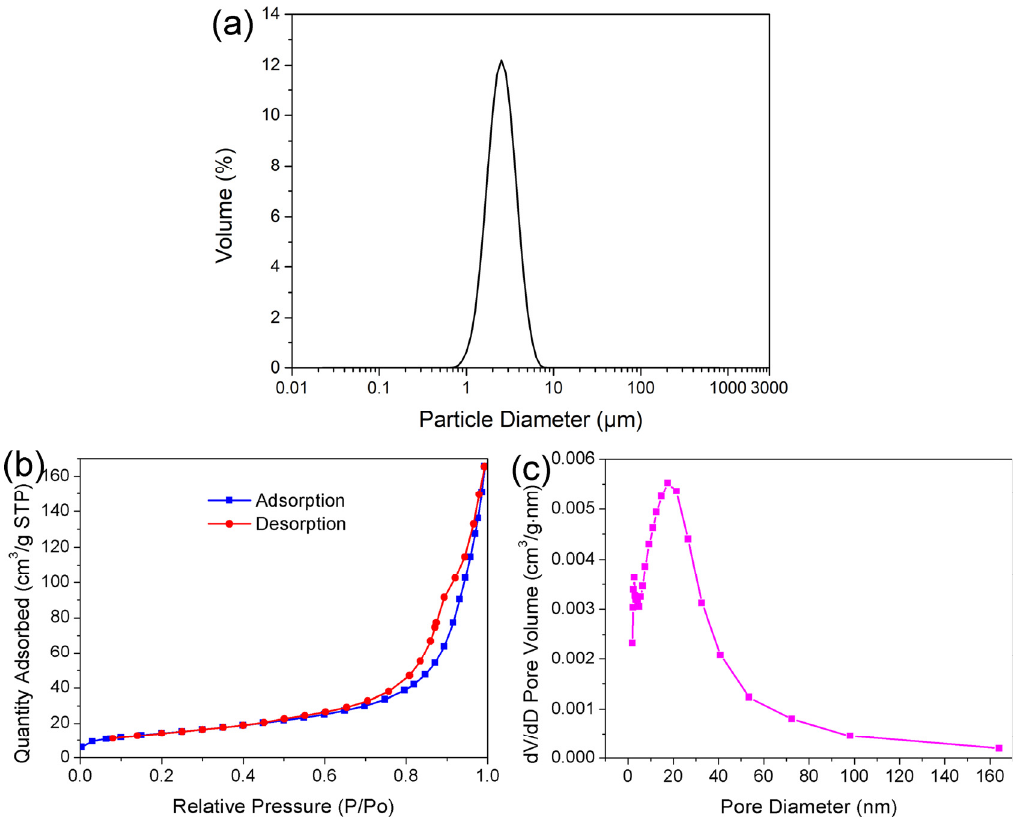
Figure 4. Particle size distributions ( a ), nitrogen adsorption–desorption isotherms ( b ), and pore size distributions ( c ) of the HA microspheres prepared with a 1:2 TSC/Ca molar ratio.